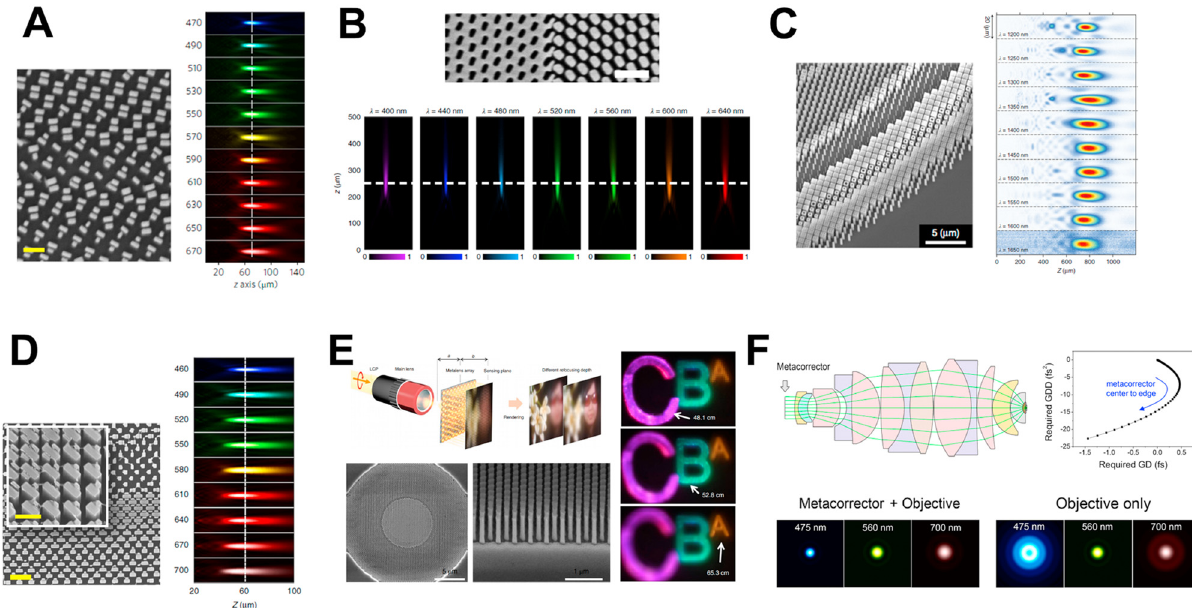
Figure 12: Dispersion-engineered continuous-band metalens. (A – B) Visible metalens. (A) Metalens based on TiO 2 nano- fi n structure. Left panel is SEM image of fabricated sample. Scale bar, 500 nm. Right panel shows measured intensity pro fi les. Adapted with permission from Ref. [11]. Copyright 2018, Springer Nature. (B) Metalens based on gallium nitride (GaN) nano-post and its inverse structure. Top panel is SEM image of fabricated sample. Scale bar, 500 nm. Bottom panel shows measured intensity pro fi les. Adapted with permission from Ref. [141]. Copyright 2018, Springer Nature. (C) Polarization-insensitive metalens with complex cross-sections. Left panel shows fabricated sample. Scale bar, 5 μ m. Right panel shows measured intensity pro fi les. Adapted from Ref. [124]. Copyright 2018, The Authors. Distributed under a Creative Commons Attribution 4.0 International License (CC BY). (D) Polarization-insensitive metalens with anisotropic structure. Left panel shows fabricated sample. Scale bar, 1 μ m. Inset shows magni fi ed and oblique view with scale bar of 500 nm. Adapted from Ref. [140]. Copyright 2019, The Authors. Distributedunder a Creative CommonsAttribution 4.0 International License (CC BY). (E) Metalens array for light- fi eld imaging. Top-left panel is schematics of light- fi eld imaging using metalens. Bottom-left panels shows fabricated sample. Scale bars, 5 and 1 μ m, respectively. Right panels show rendered images with focusing depths of 48.1, 58.2, and 65.3 cm, respectively. Adapted with permission from Ref. [143]. Copyright 2019, Springer Nature. (F) Broadband meta-corrector. Top-left panel shows complex optical system corrected by meta-corrector. Top-right panel shows required group delay and group delay dispersion. Bottom panels show results measured with and without meta-corrector. Adapted with permission from Ref. [149]. Copyright 2018, American Chemical